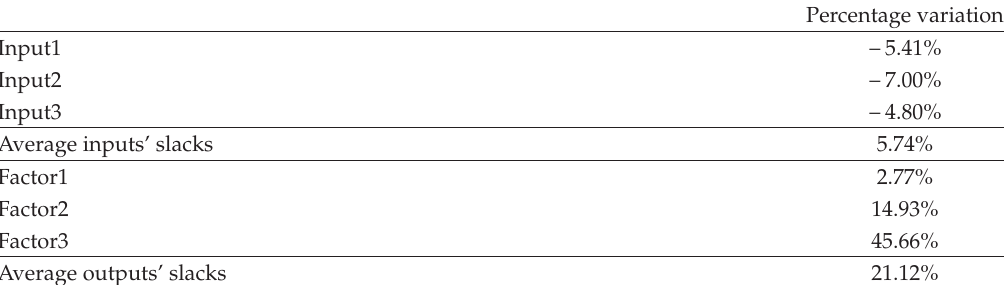
Table 8: Potential average savings and increases (cid:3) BCC input-oriented model (cid:4)